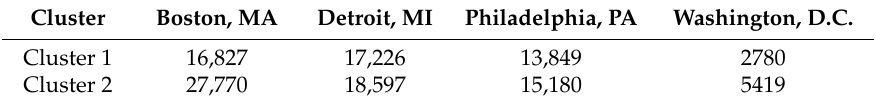
Figure 9. A comparison between a set of features for the two clusters.